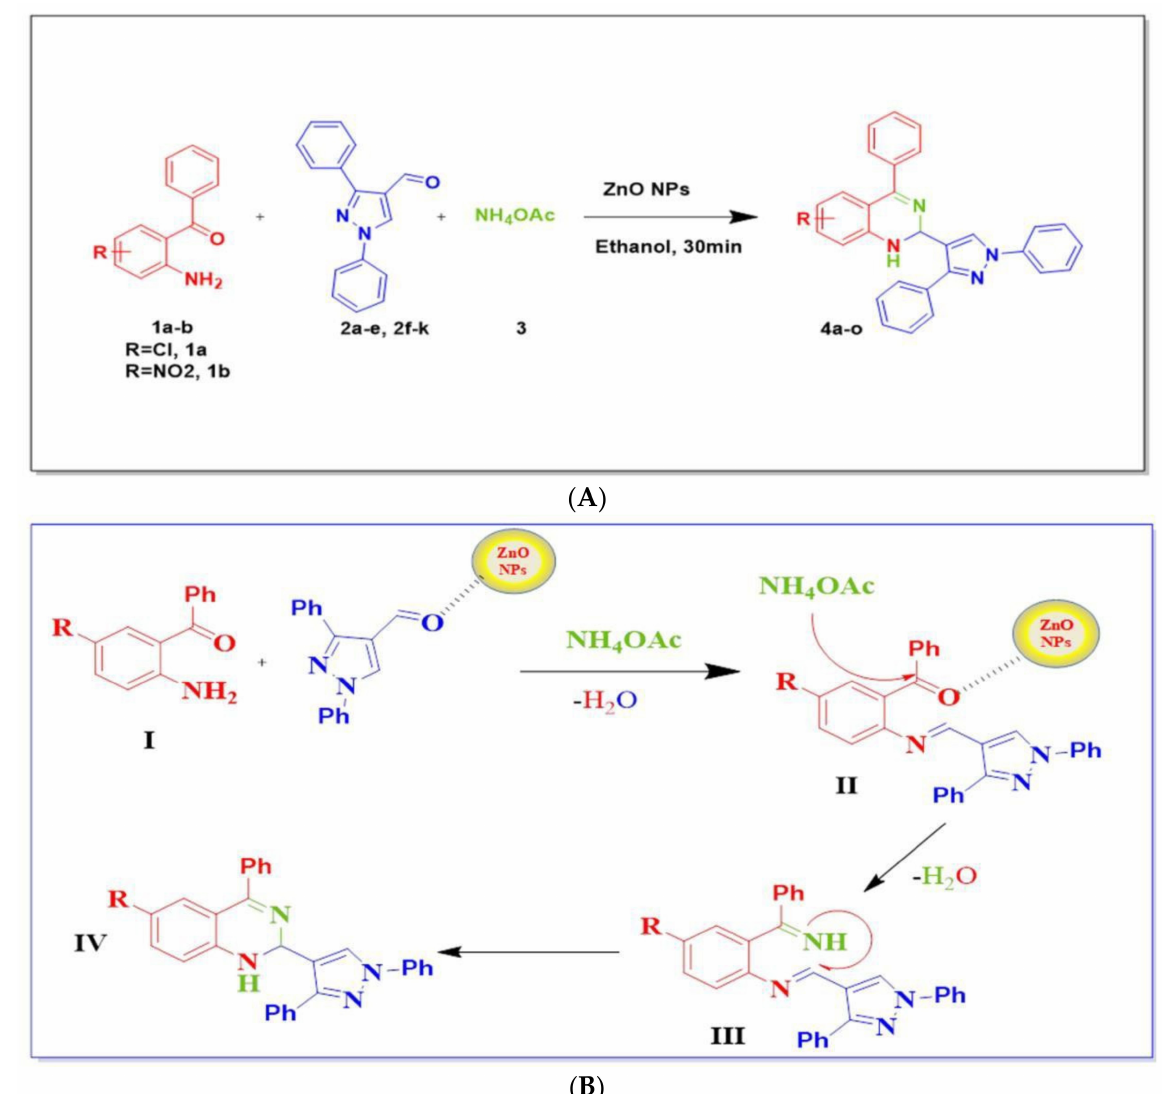
Figure 8. ( A ) Synthesis of 2-(1,3-diphenyl-1H-pyrazol-4-yl)-4-phenyl-1,2-dihydroquinazoline deriva- tives. ( B ) A plausible mechanism for the synthesis of 1,2-dihydroquinazolines by ZnO